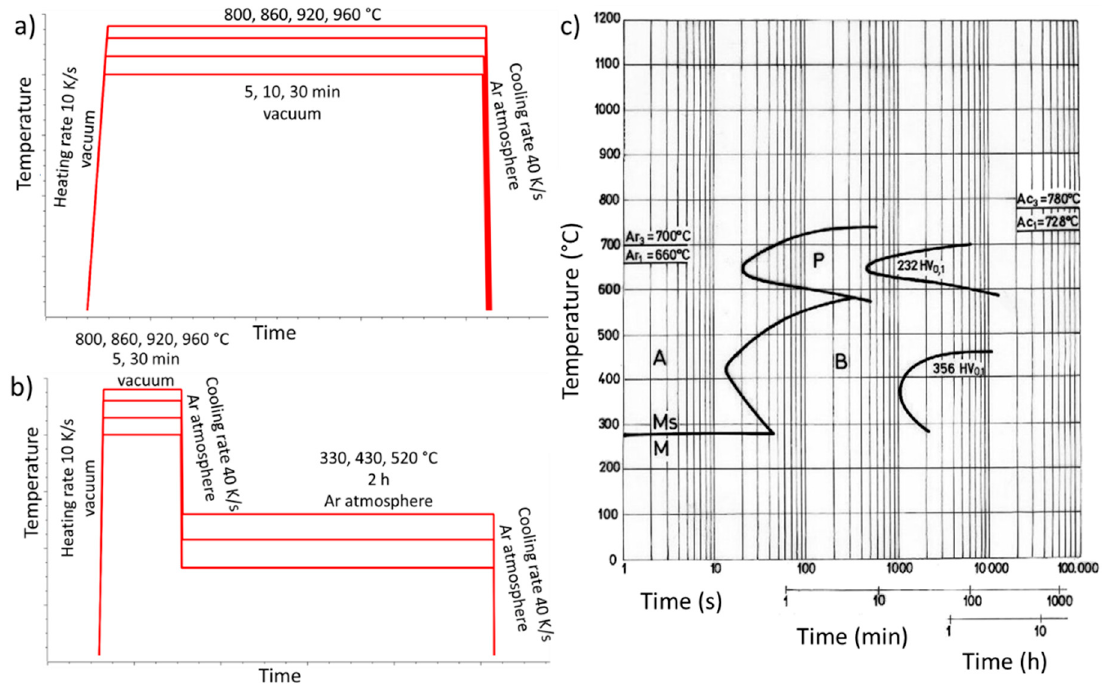
Figure 2. ( a ) Heat treatment regime of different austenitisation time-temperature combination, ( b ) heat treatment regime of different isothermal bainite transformation and ( c ) isothermal transformation diagram for 51CrV4 steel adapted with permission from Reference [22]. 2022, SIJ Metal Ravne, d.o.o.